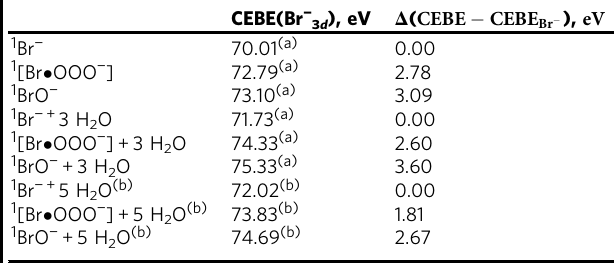
Δ ( CEBE (cid:1) CEBE Br (cid:1) ) is the energy difference (in eV) between the species and the bromide, taken as a reference. CEBE marked with (a) are calculated on the top of MP2 optimized geometries. CEBE marked with (b) are averaged over the values obtained from fi ve different snapshots extracted from the fi rst-principles MD